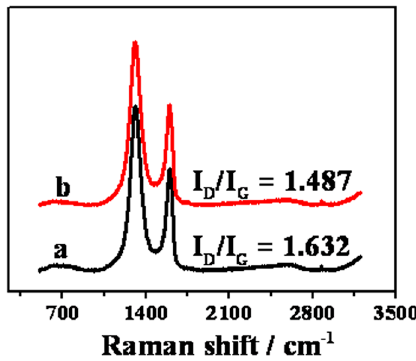
Figure 5. Raman spectra of Pt/GNs (a) and Pt ‐ Ag/GNs (b).